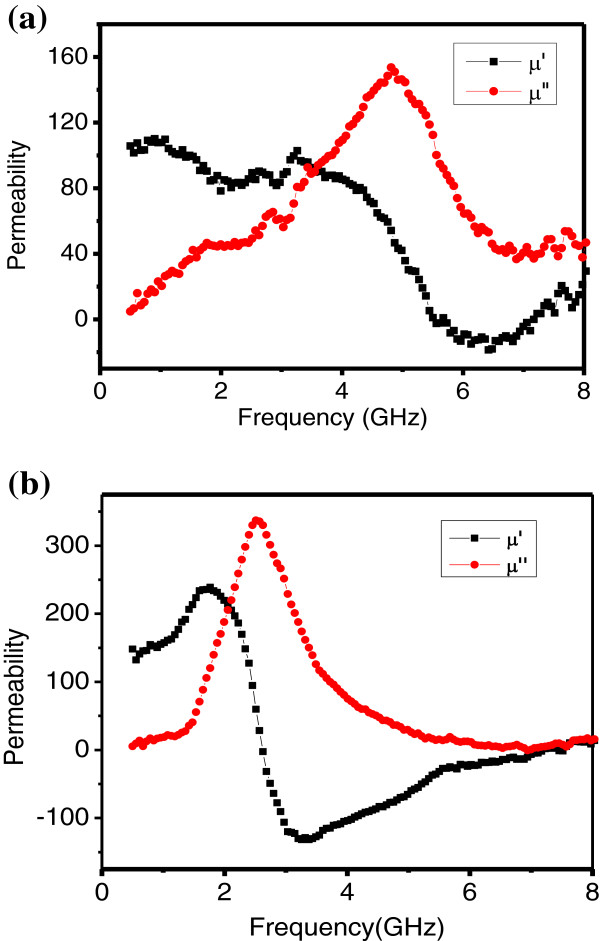
The complex permeability of the films: (a) FeCo-SiO2monolayer, (b) FeCo/(FeCo)0.63(SiO2)0.37 multilayer.